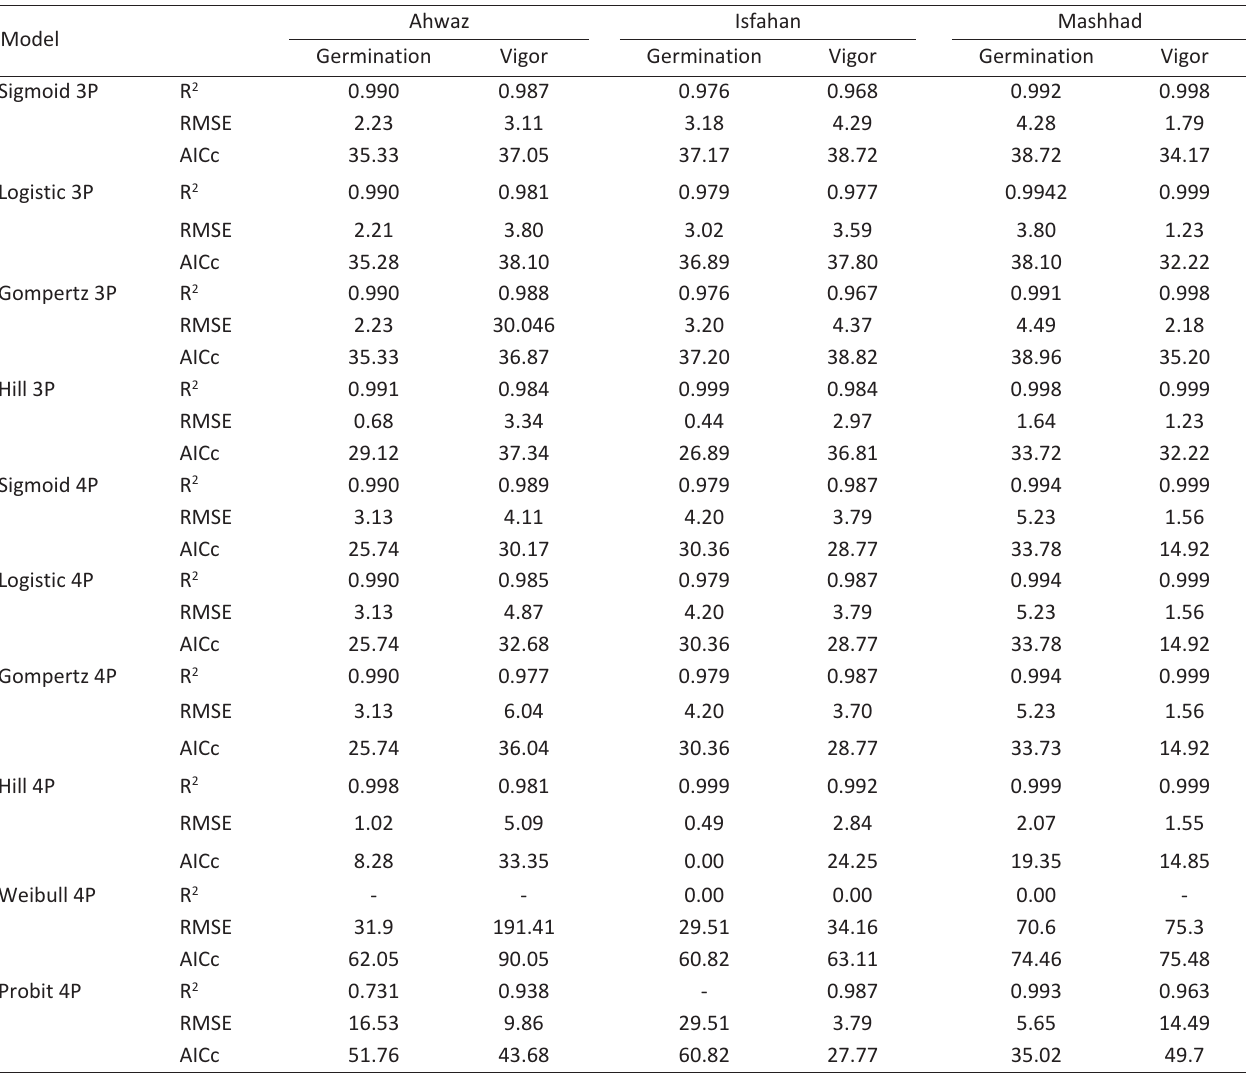
Table 2 - Comparative indices of models performance to describe seed germination and vigor of okra ecotypes